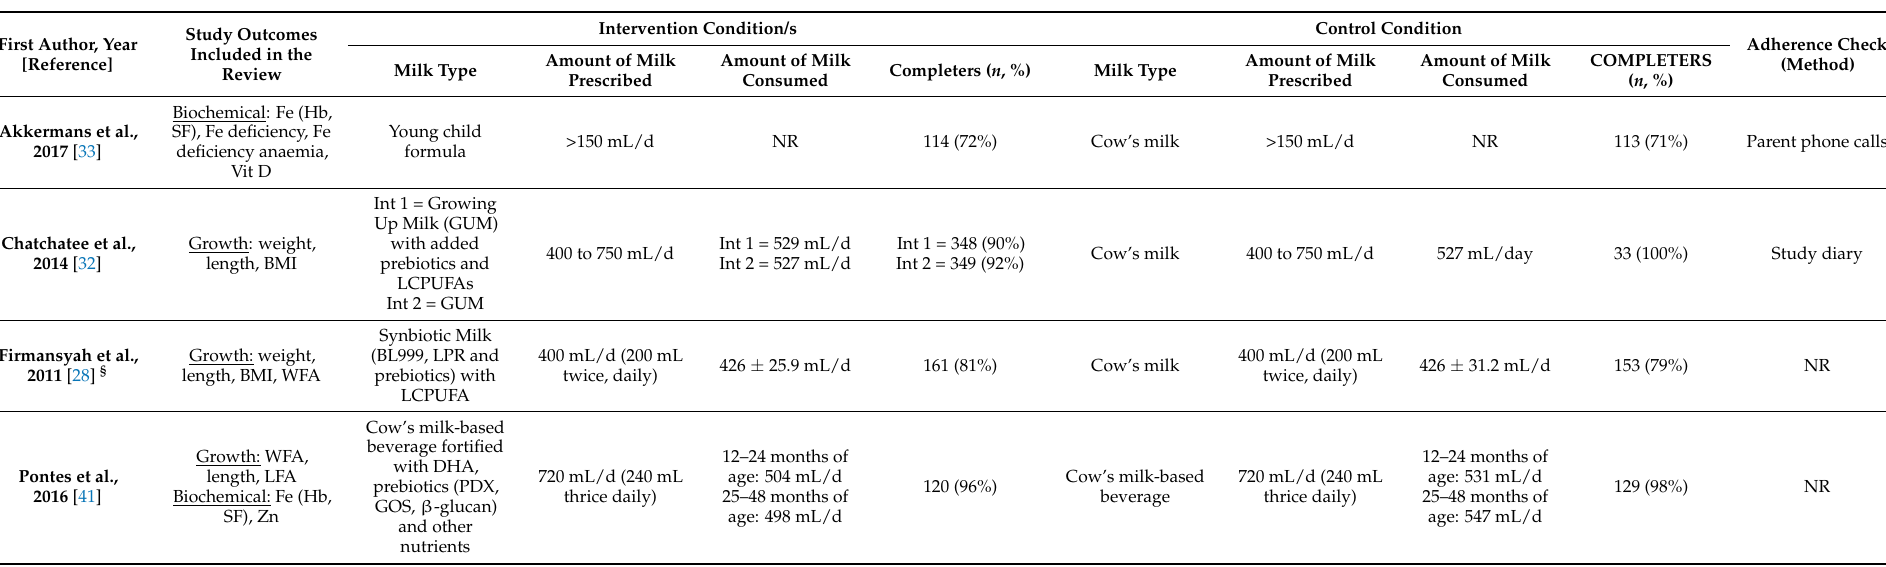
Table 3. Intervention data and outcome